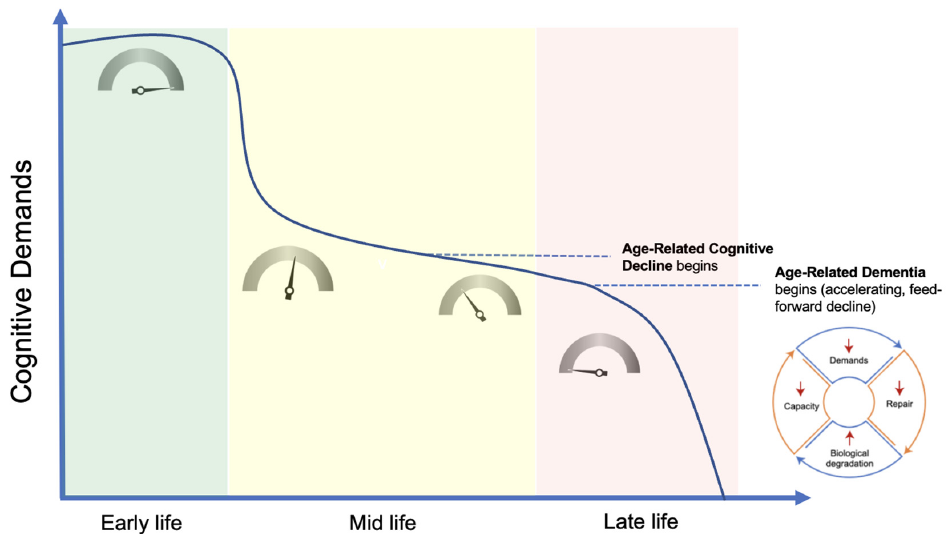
Figure 3. Demand-driven model. In early life, numerous factors, most notably the neuro-develop- mental program, maintain maximal cognitive demands and, via demand coupling, a maximal growth and repair signal (as indicated by the inset dials). Relative to early life, demands drop con- siderably in mid-life, leading to a steady deterioration in tissue structure and function, along with the onset of age-related cognitive decline. Once deterioration in tissue structure significantly con- strains the scope of potential cognitive demands, a non-linear, accelerating rate of decline ensues, progressing to clinical dementia. Created with BioRender.com . 10. Future Directions, Therapeutic Implications, and Conclusions While some attention has been directed towards the influence of lifestyle and envi- ronmental factors on disease risk, the direct influence of declining cognitive demands over the lifespan on disease pathogenesis has been overlooked. There are two primary reasons why it is critical that its role be accounted for in therapeutic investigations. First, it is presently unknown whether the maintenance of the nature and scope of cognitive demands to a degree comparable to that of early life would be enough to prevent the disease state entirely. Likewise, it is unknown whether sustained reductions in cogni- tive demands alone are enough to produce the disease state. Existing programs for provid- ing brain stimulation as a means of mitigating cognitive decline do not provide a degree of cognitive challenge comparable to that of the developmental program of early life, fo- cusing on a restricted subset of cognitive capabilities, typically bypassing large regions of cortex, including those involved with the acquisition and maintenance of complex motor skills and social behaviors. While the modest results to date offer proof of concept, it is unlikely that programs of this nature will provide a stimulus necessary to fully halt or reverse course of these conditions. In our view, candidate activities for providing suffi- cient stimulus to maintain tissue integrity must provide a robust and ongoing challenge to broadly distributed, multimodal cognitive networks. The activities we propose most likely to induce the necessary demand and adaptation, such as language, music, and dance, are also those that are inherently “human,” and which not by coincidence drove the evolution of the cognitive capabilities we seek to preserve (Table 2). Second, the maintenance of demands above a certain threshold may be a necessary condition for the preservation and restoration of cerebral tissue, and as such may preclude the success of therapeutic interventions intended to support restoration and repair of dis- eased tissue. In other words, efforts to ameliorate AD pathology, including agents previ- ously tested in randomized clinical trials, may only be helpful in the presence of a